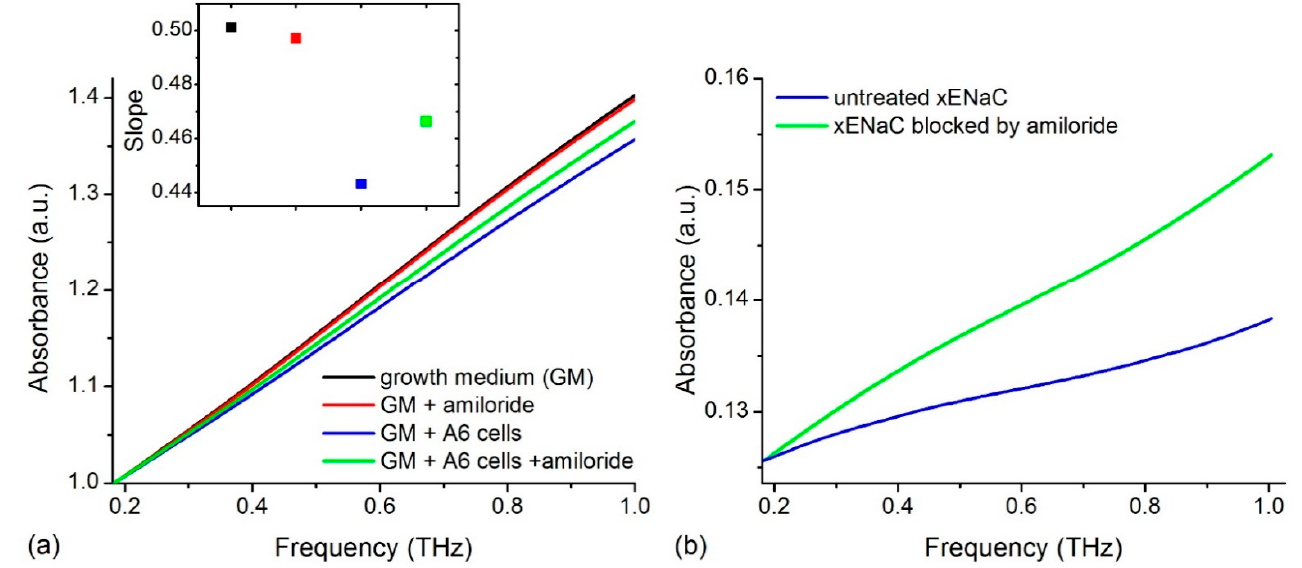
Figure 1. ( a ) THz spectra of growth medium (GM), 100 µM amiloride solution in GM (GM + amiloride), A6 cells suspension in GM (GM + A6 cells) and A6 cells suspension in GM treated with 100 µM amiloride (GM + A6 cells + amiloride). Spectra were translated on Oy axis such that all absorptions start at the same point (1 a.u.). The slopes of the lines that fit the spectra are presented in the insert. The colors used to represent the slopes match the colors used to represent the spectra; ( b ) The THz absorbance of A6 cells untreated and treated with amiloride obtained by subtracting the contribution of solvent from the absorbance of cells’ suspensions.